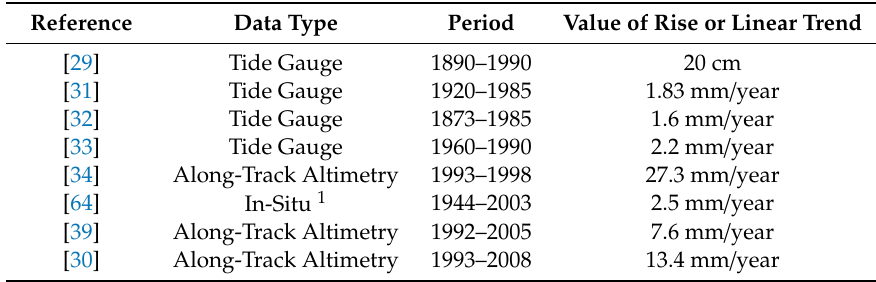
Table 4. Estimates of the rate of the basin-averaged sea level rise in the Black Sea.